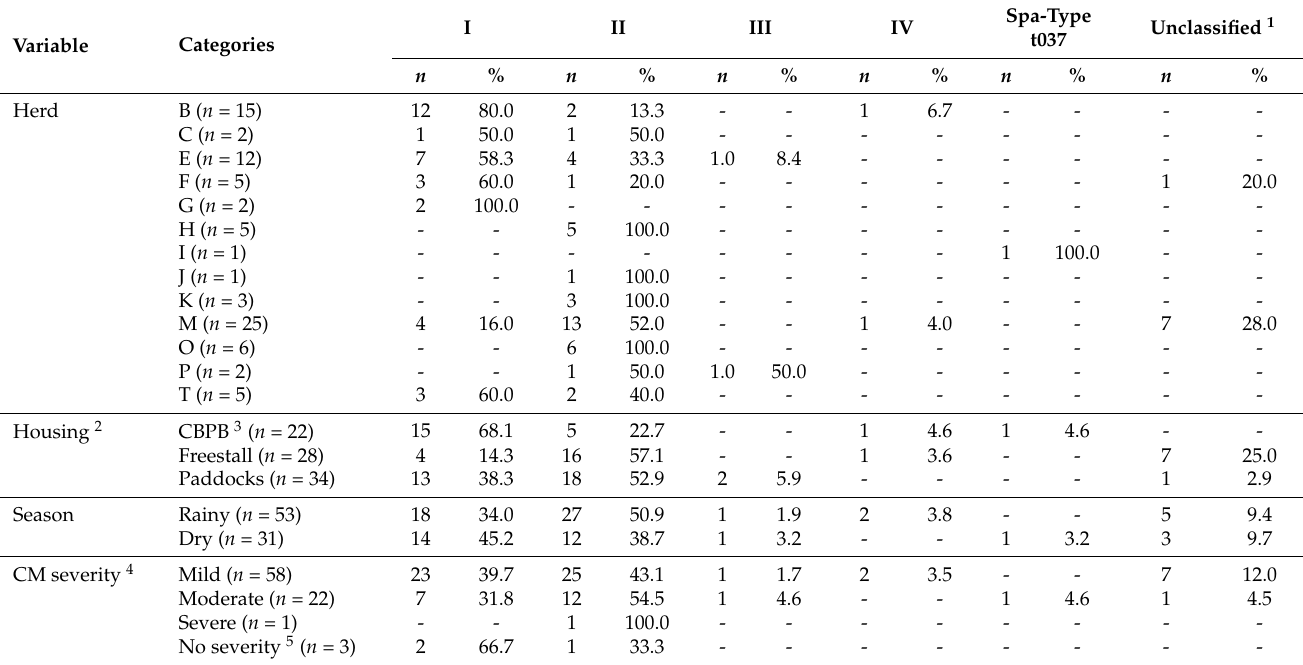
Table 1. Distribution of 84 Staphylococcus aureus isolates recovered from affected mammary quarters of cows with clinical mastitis according to spa-typing clusters, herd of origin, housing system, season, and severity score of clinical mastitis.